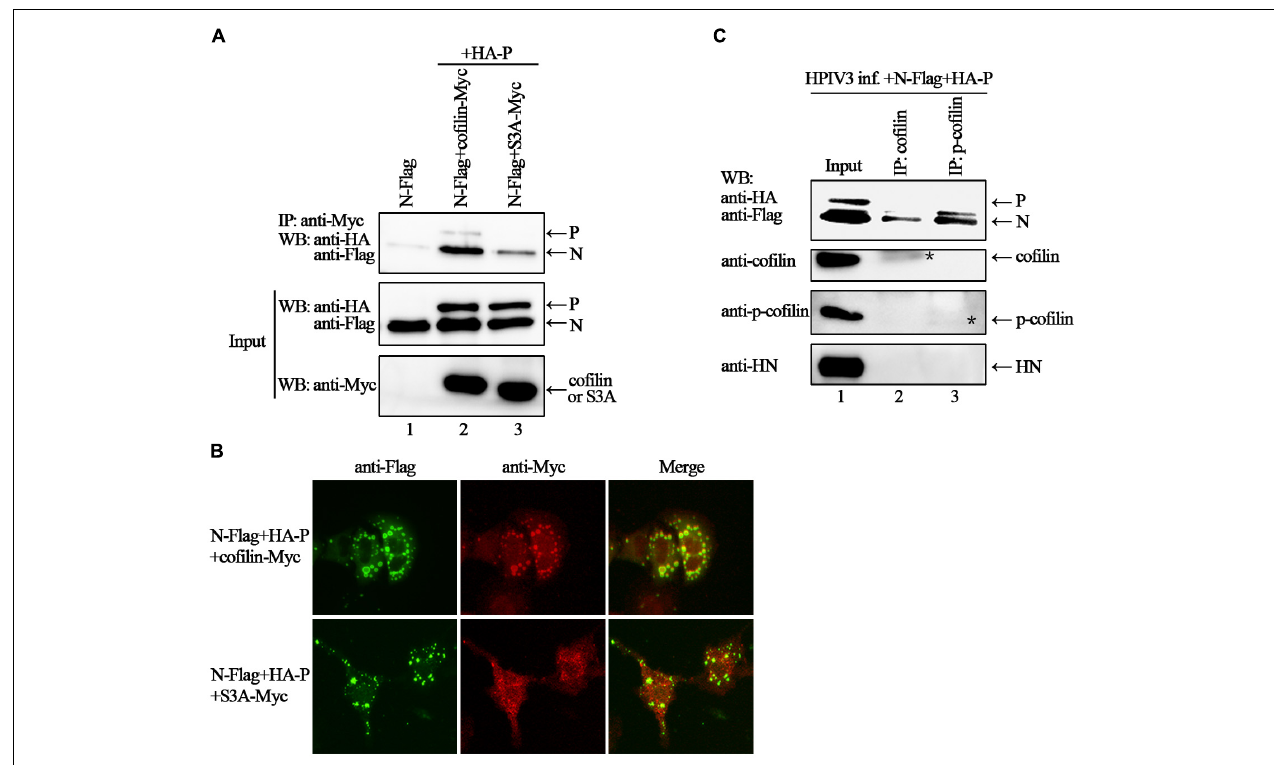
FIGURE 6 | Phosphorylation is required for cofilin to associate and colocalize with N–P complex. (A) 293T cells were transfected with plasmids encoding N-Flag, HA-P, cofilin-Myc and S3A-Myc individually or jointly as indicated. At 48 h after transfection, the cells were collected and processed to co-IP assays as described in the legend of Figure 2A . Proteins were precipitated with anti-Myc antibody and examined by WB. (B) Hela cells were transfected with plasmids encoding N-Flag, HA-P and cofilin-Myc or S3A-Myc. At 24 h after transfection, the cells were fixed, and rabbit Flag primary antibody and goat anti-rabbit AF488 were used to stain N, and mouse Myc primary antibody and goat anti-mouse AF568 were used to stain cofilin. Images were analyzed via IF microscope. (C) Hela cells were infected with HPIV3 at MOI of 1 for 1 h, and then plasmids encoding N-Flag and HA-P were transfected. At 24 h posttransfection, the cells were collected and processed to co-IP assays as described in “Materials and Methods” section. Proteins were precipitated with anti-cofilin or p-cofilin antibodies and examined by WB. The stars indicated the bands of precipitated cofilin or p-cofilin.